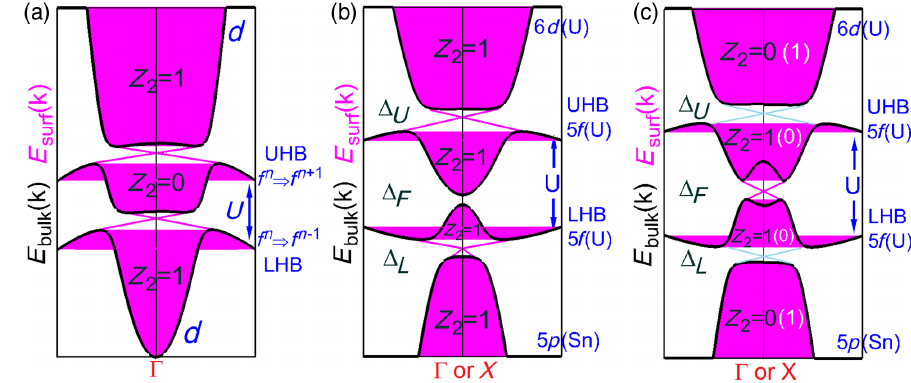
FIG. 3. Band inversion mechanism applicable for UNiSn. (a) In the periodic Anderson model, hybridization between a wide d band centered at the k ¼ 0 Γ point and f -electron multiplet transitions [lower and upper Hubbard bands (LHB and UHB, respectively)] results in three energy panels (shown by black lines) and two gaps that are both topologically nontrivial. The corresponding surface spectrum is shown by magenta, where the spectral weight of the Dirac cone is distributed between the two gaps. (b) In UNiSn, the upper Hubbard band is inverted with the wide 6 d band of uranium, while the lower Hubbard band is inverted with the 5 p band of tin, resulting in four energy panels and three gaps. With two such band inversions, upper ( Δ ) and lower ( Δ ), the hybridization gaps are topological, U L while the fundamental bulk gap Δ is not. (c) The band inversion between U 6 d and Sn 5 p states around the zone boundary X point F makes the fundamental gap Δ topological. The topological features of the gaps Δ and Δ are seen to disappear in the LDA þ DMFT F U L calculation, but this disappearance is not a requirement within the considered model ( Z 2 invariants shown in parentheses are